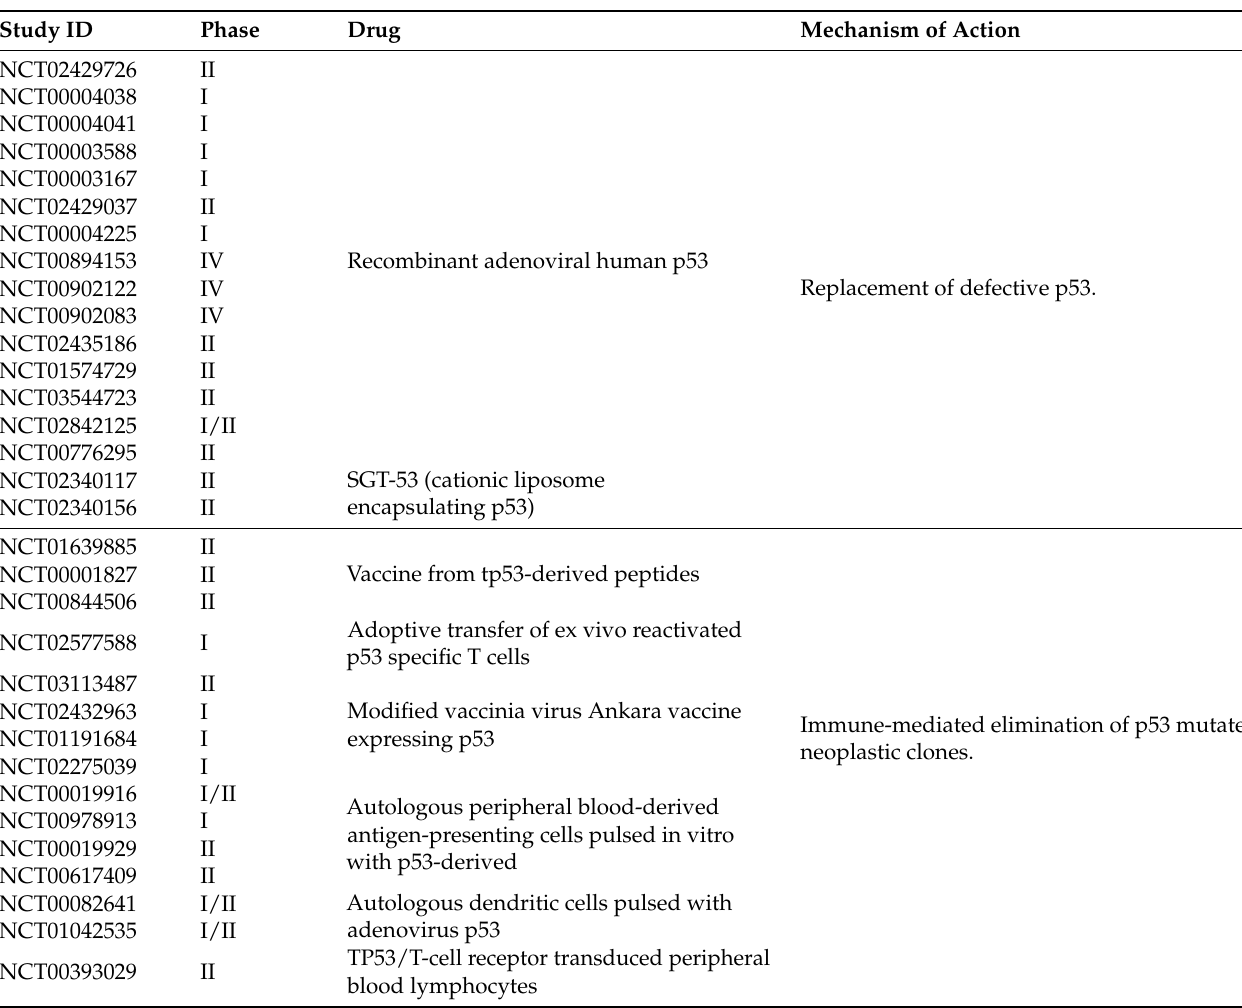
Table 2. Examples of clinical studies exploring p53-oriented therapies in solid